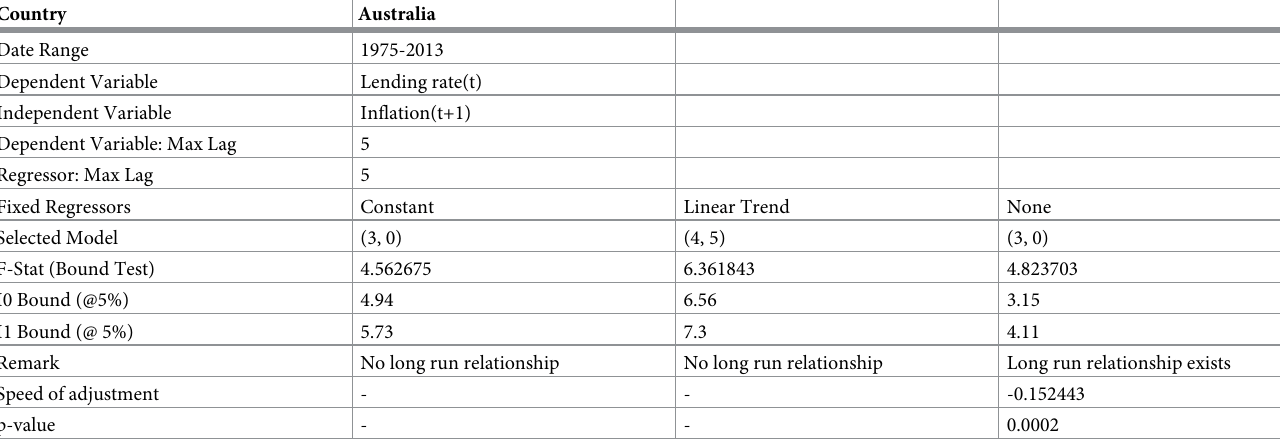
Table 25. ARDL Bounds Testing for Australian data under Fisherian